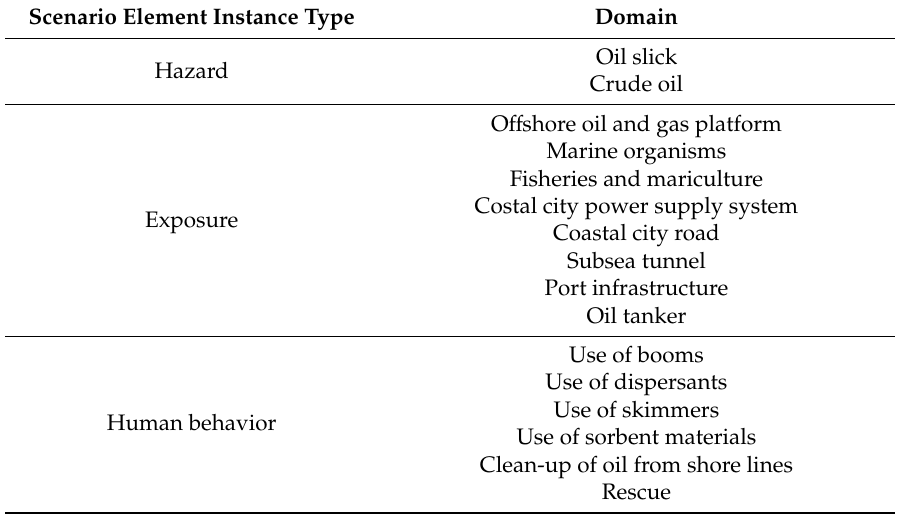
Table 1. Summary of scenario elements and domains related to marine oil spill events.